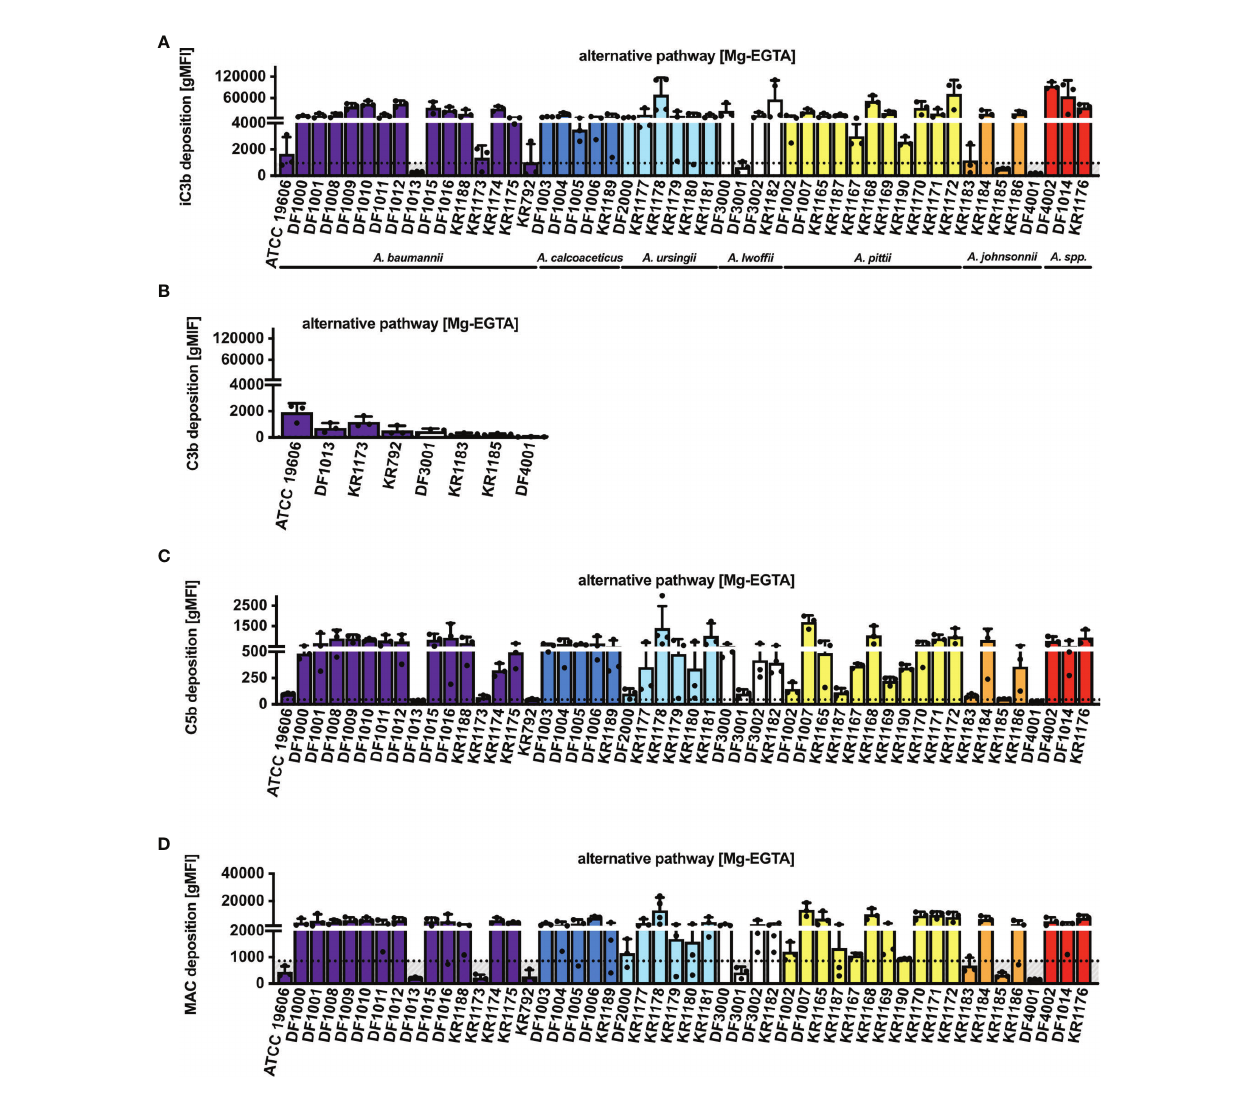
FIGURE 3 | Complement deposition on Acinetobacter isolates via alternative pathway (Mg-EGTA buffer). Deposition of (A) iC3b, (B) C3b, (C) C5b and (D) MAC on bacterial surface in NHS. Bars represent gMFI ± SD of at least 3 independent experiments; horizontal dotted line represents gMFI (average + SD) measured in NHS with EDTA acting as a deposition